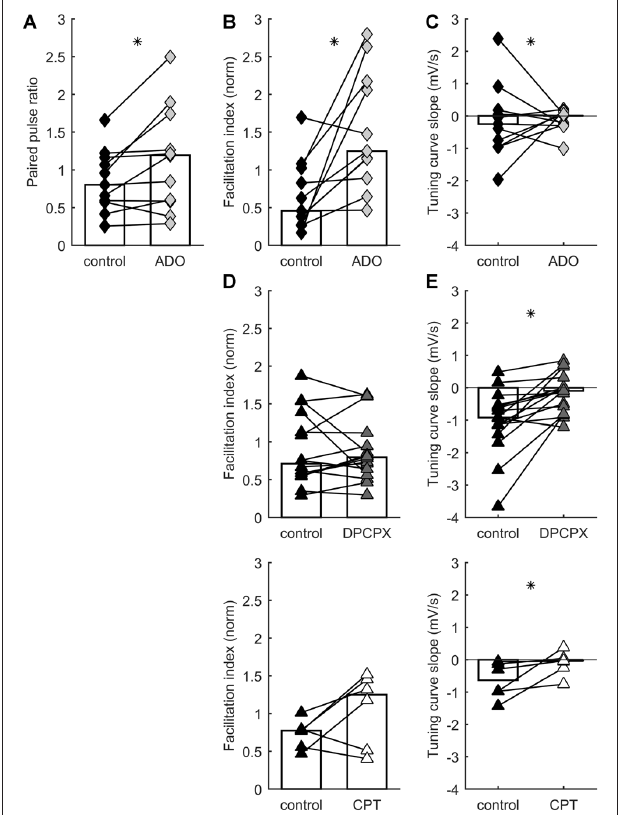
FIGURE 2 | STP distribution is regulated by A1 adenosine receptor activation . Each connected pair of points is one recording. Bars represent population median. Asterisks denote statistically significant difference between distributions (tests are indicated in main text). (A) Adenosine application increases paired pulse ratio. (B) Adenosine application increases facilitation index. (C) Adenosine has no systematic effect on TCS. (D) A1 receptor blockade by DPCPX (top) or CPT (bottom) has no systematic effect on facilitation index. (E) A1 receptor blockade by DPCPX (top) or CPT (bottom) increases